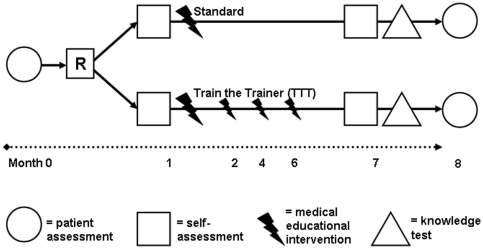
Trial design.(in chronological order:) Patient enrolment by primary care physicians and baseline clinical documentation (patient assessment), randomisation of physicians (with patients in clusters), physician self-assessment of competencies before (first) medical education intervention (either TTT or Standard), second physician self-assessment before unheralded knowledge test, follow-up patient assessment.